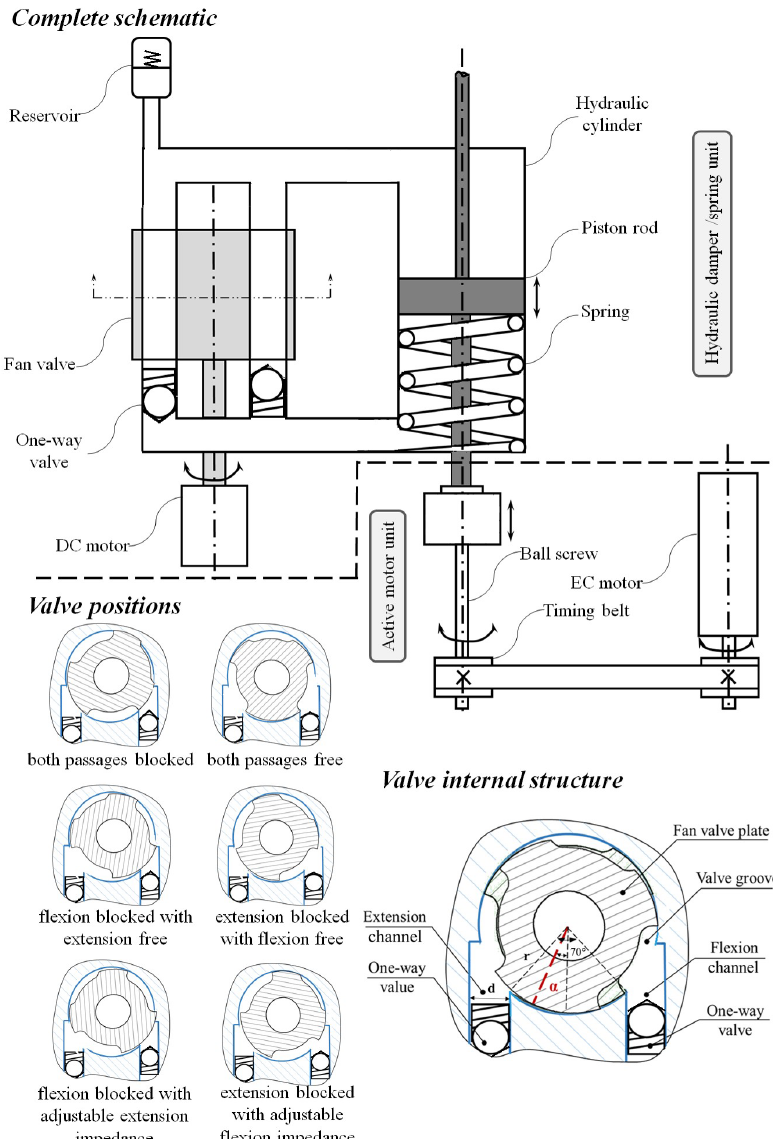
Figure 5. The internal mechanical schematic for the